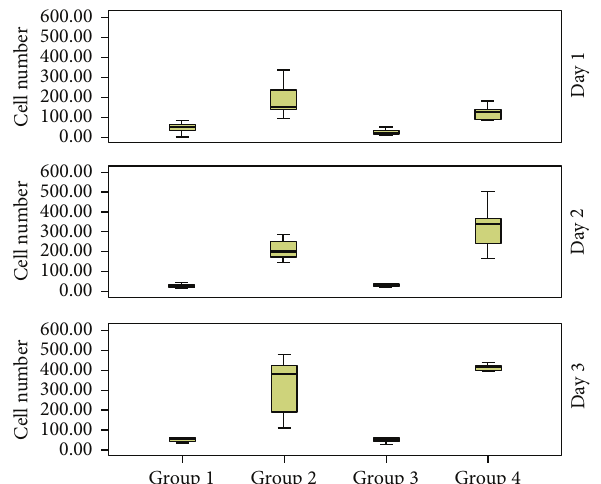
Figure 4: Number of mesenchymal cells observed on days 1, 2, and 3 in accordance with the experimental group. 𝑃 values: a = 0.006, b = 0.0027, c = 0.001, d = 0.001 and = 0.001, f = 0.001, g = 0.002, h = 0.001, i = 0.001, j = 0.001, k = 0.001, l = 0.001, m = 0.001, and n = 0.001.